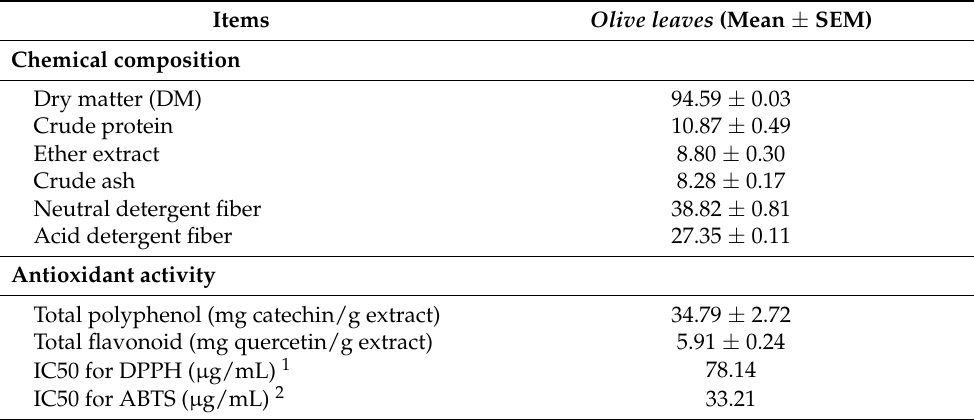
Table 2. Chemical composition and antioxidant activity of olive leaves (OLs) (DM basis, %). Items Chemical